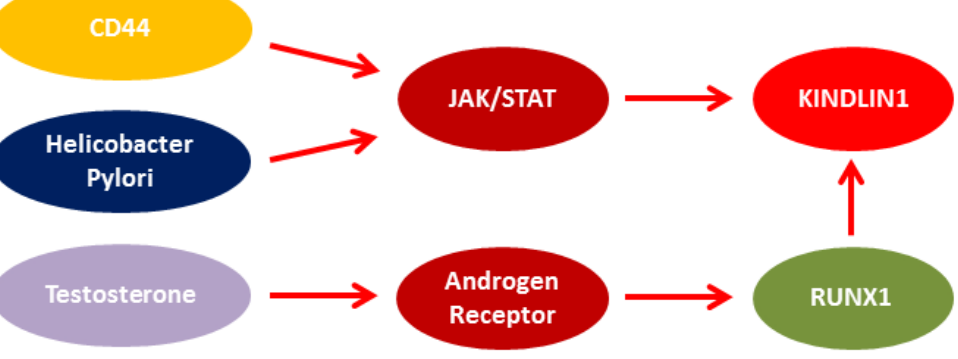
Fig. 2. Probable correlation between KINDLIN1, sex, tumor location, and Helicobacter